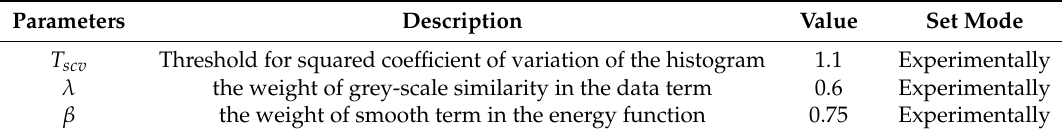
Table 1. The key parameters of the proposed method.